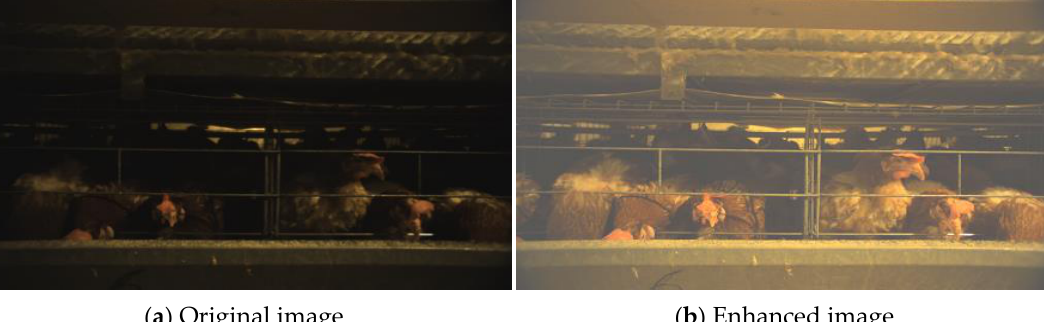
Figure 2. Image sample of hens.